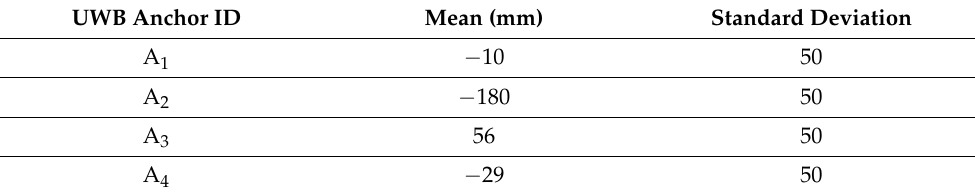
Table 1. Mean and standard deviation of distance measurement used in the simulation.